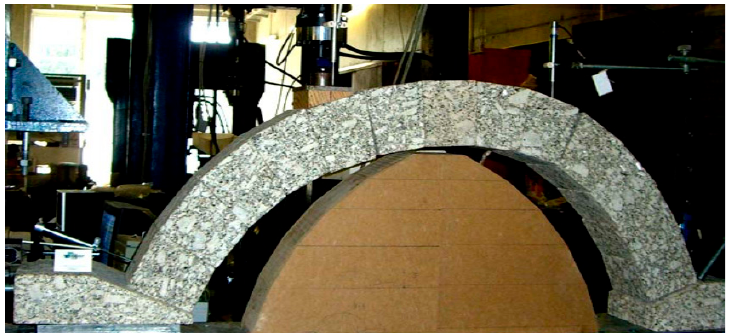
Figure 2. Deformed arch shape at the ultimate displacement (12 mm), reproduced from [35].